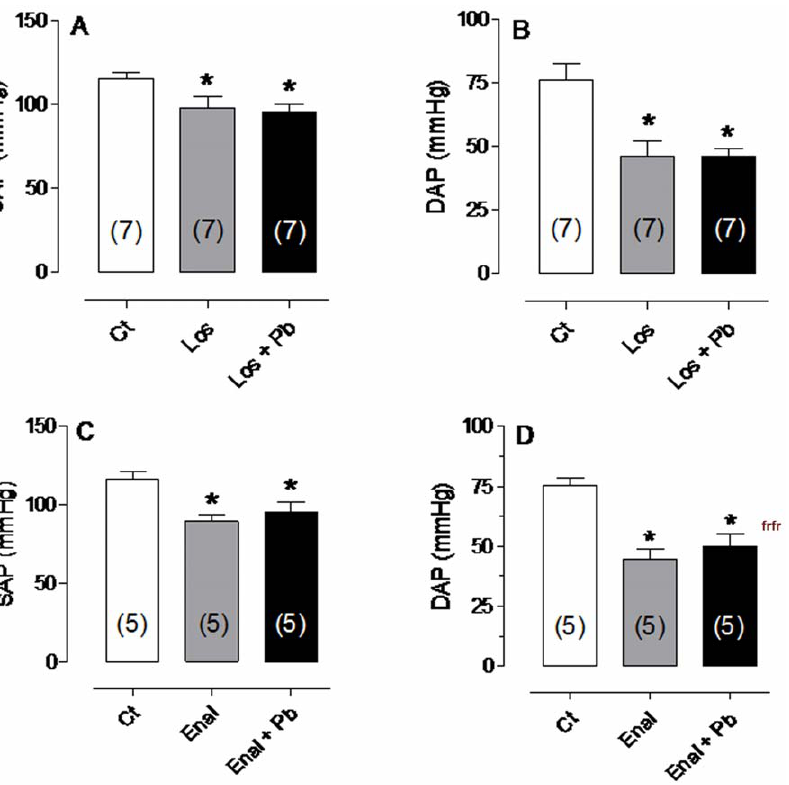
Figure 1. Changes in arterial pressure. Changes in systolic arterial pressure-SAP (A and C) and diastolic arterial pressure-DAP (B and D) before (Ct) and after Losartan (Los) or Enalapril (Enal) administration and following lead exposure (Los + Pb; Enal + Pb). A and B show the Losartan protocol; C and D show the Enalapril protocol. *p , 0.05 compared with untreated controls. The number of animals used is indicated in parentheses.